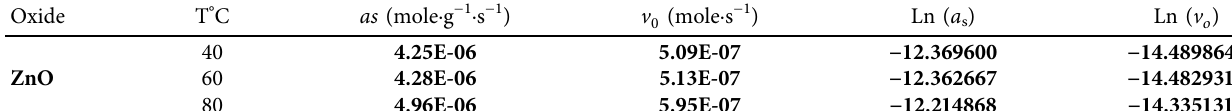
Table 2: Kinetic settings of the reaction of the decomposition of isopropanol.